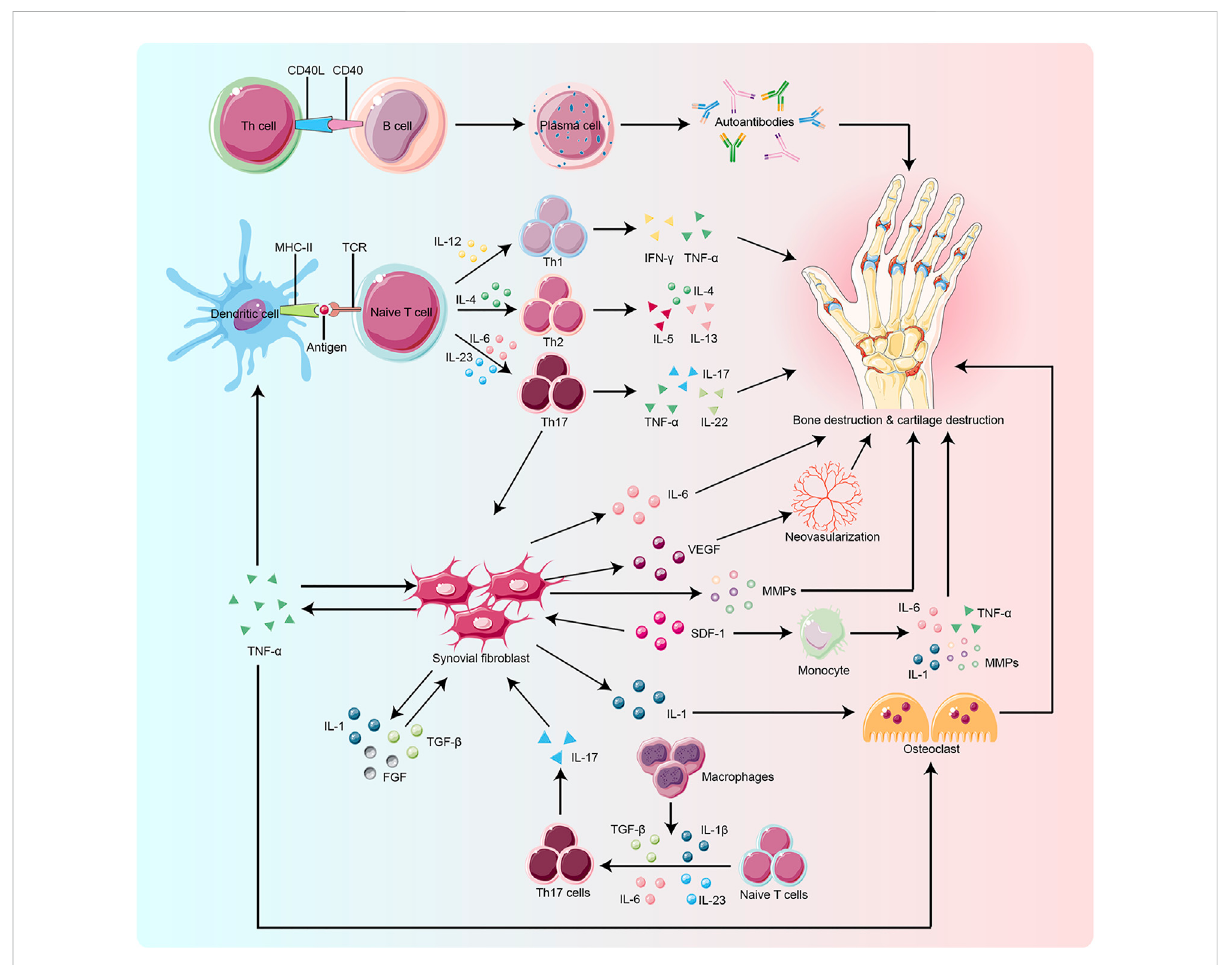
FIGURE 1 KeytargetandeffectorcellsareinvolvedinthepathogenesisofRA.NaïveTcellactivationisinducedbyspeci fi crecognitionofTCRandantigens presented by MHC-II molecules of antigen-presenting cells (APCs), such as dendritic cells, which are the most potent APCs. Cytokines produced by activated Tcells and APCs in fl uence T cell differentiation. IL-12, IL-4, and IL-23 play akey role in the differentiation of naïveT cells into Th1, Th2, and Th17 cells, respectively. Macrophages also promote Th17 differentiation by secreting cytokines such as TGF- β and IL-23. Upon activation and differentiation, more cytokines, including TNF- α , TGF- β , IL-1, SDF-1, and FGF, are secreted to promote the proliferation of RA-FLS. RA-FLS, in turn, secrete active substances like IL-6, MMPs, and TNF- α , to aggravate bone erosion and VEGF to promote neovascularization. The CD40/CD40L interactions activate B cells to produce autoantibodies which play a critical role in bone resorption. SDF-1 also activates monocytes to produce IL-1, IL-6, MMPs, and TNF- α , which lead to bone degradation. Osteoclasts are mainly activated by IL-1 and TNF- α , which ultimately promote bone destruction.TCR:T cellreceptor,MHC-II:MajorHistocompatibilityComplexClassII,APCs:antigen-presentingcells,ILs:interleukins,Th:Thelpercell, TGF- β :transforming growth factor- β , TNF- α :tumor necrosis factor- α , SDF-1:stromal cell-derived factor-1, FGF: fi broblast growth factor, RA-FLS: rheumatoid arthritis- fi broblast-like synoviocytes, MMPs:matrix metalloproteinases, VEGF:vascular endothelial growth factor, CD40:clusters of differentiation 40, CD40L:clusters of differentiation 40